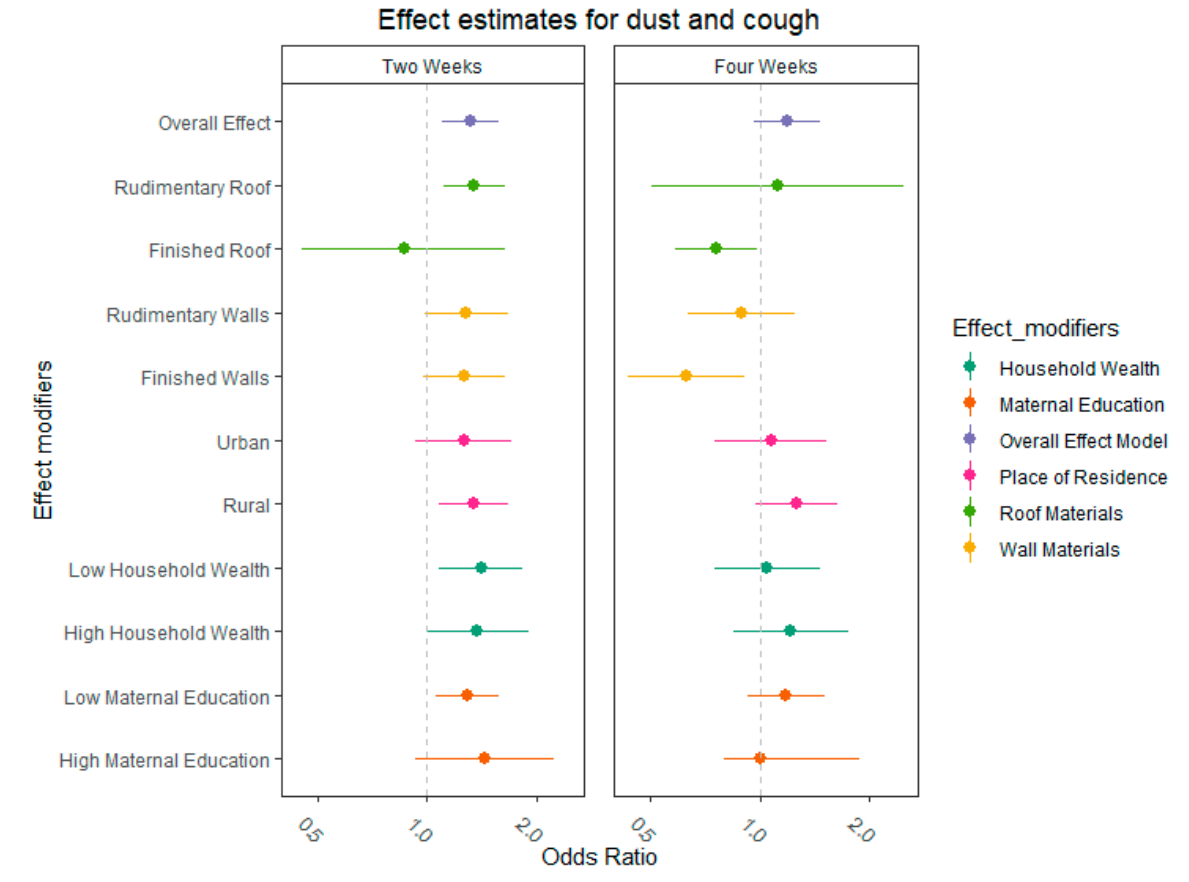
Figure 3. Odds ratios of overall effect model and models examining effect measure modification for both two- and four-weeks periods prior to the interview date. Each color represents a different effect modifier.